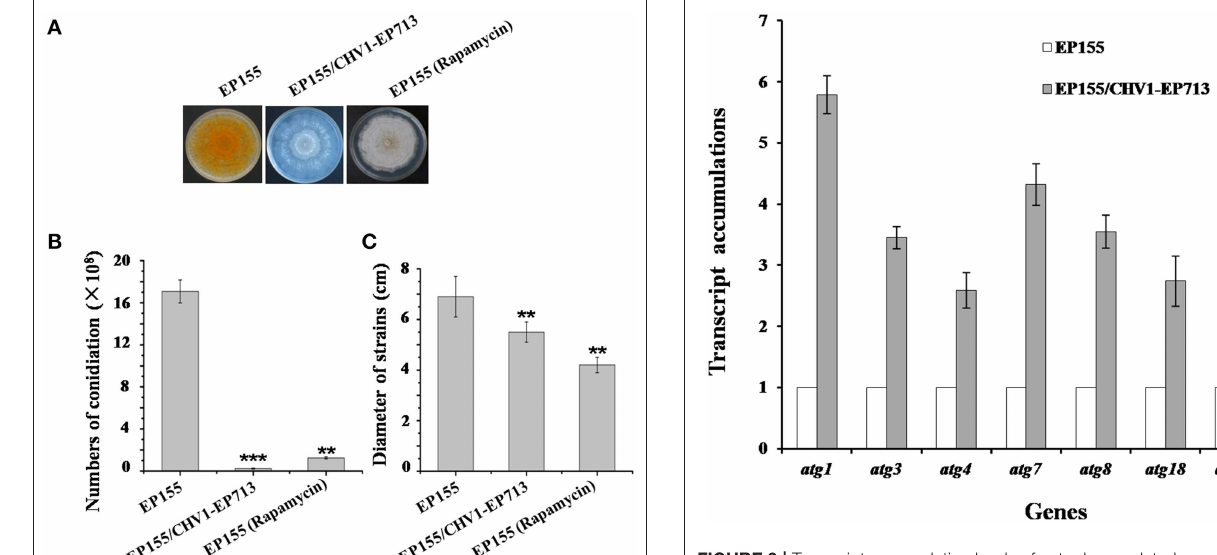
FIGURE 3 | Transcript accumulation levels of autophagy-related genes. The transcript accumulation level for each of the target genes in EP155 was set at 1.0, and the corresponding levels in EP155/CHV1-EP713 were expressed as a percentage of that of EP155. Values were calculated from three biological repeats. Bars indicate mean